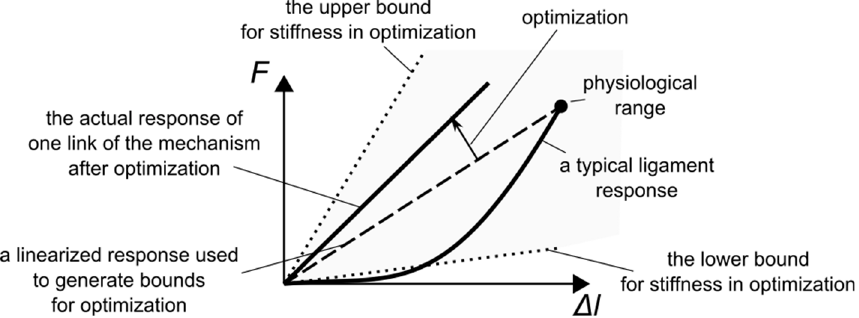
Figure 2. The force-elongation curves for an actual ligament, a linearized cable used in generating bounds for the optimization procedure, and a cable after optimization.